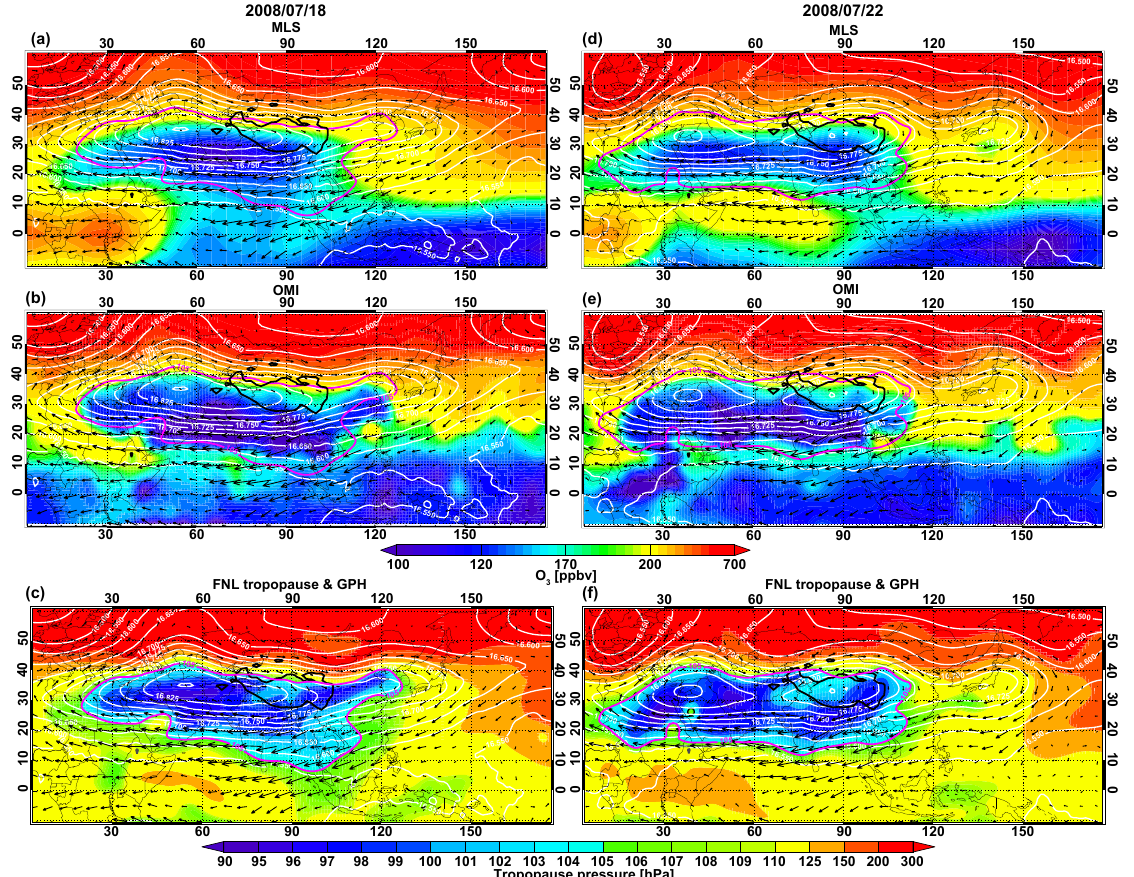
Figure 13. Daily maps of MLS O 3 mixing ratio at 100hPa and OMI O 3 mixing ratio in layer 18 (color shading) for 18 July (a, b) and 22 July (d, e) 2008. Tropopause pressure maps for the same selected two days are shown in (c, f) . Dynamical fields of GPH (white contours), horizontal winds (gray arrows), and 105hPa tropopause pressure contour (pink) are superimposed. MLS maps are interpolated using the natural neighbor method on 5 ◦ × 5 ◦ longitude–latitude grids while OMI maps are interpolated on 1 ◦ × 1 ◦ longitude–latitude grids. The tropopause pressure is from the GFS product. A Gaussian smoothing is applied to all maps. The location of the Tibetan Plateau (using 3km elevation) is also shown in the